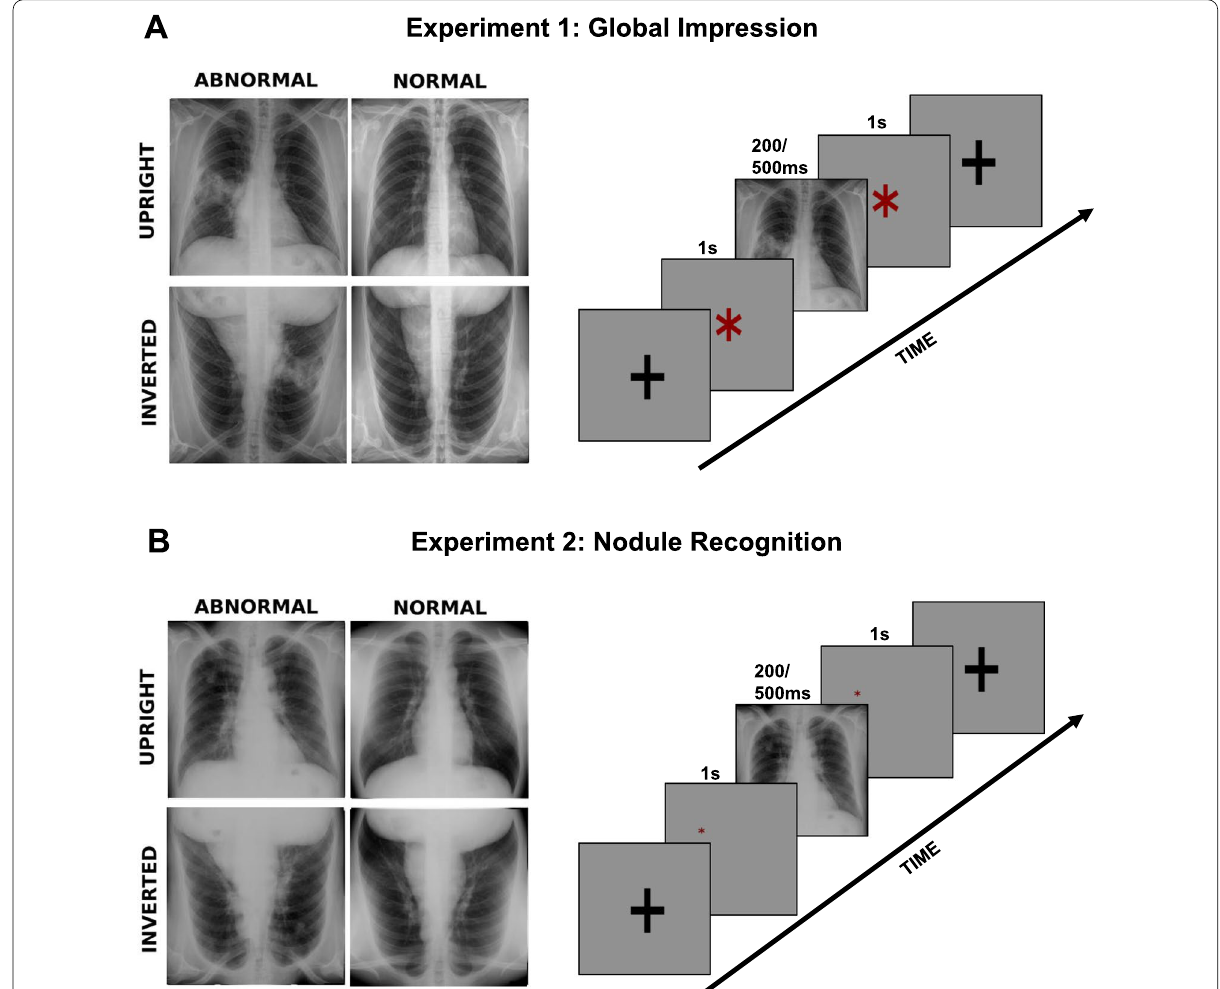
Fig. 1 Design and Stimuli. A In the first experiment (global impression), radiologists and medical students were presented with thorax X-rays with lesions (abnormal) and without lesions (normal) in an upright and inverted orientation for 200 ms or 500 ms. Before the actual presentation of X-rays, a screen lasting for 1000 ms was presented, preparing the participants for the upcoming stimulus. After the X-ray had disappeared, another screen was presented where the participants had to indicate their response. B In the second experiment (nodule recognition), radiologists and medical students were presented with thorax X-rays in an upright and inverted orientation for 200 ms or 500 ms. Before the actual presentation of X-rays, a preparation screen with the cue where the supposed nodule would appear was shown for 1000 ms. After the X-ray had disappeared, another screen was presented where the participants had to decide whether the tissue presented contained a